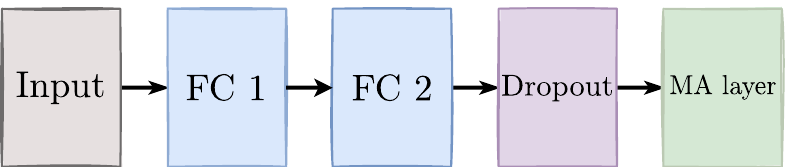
Figure 2. GCECDL-based fully connected architecture for tabular databases. FC stands for a fully connected (dense) layer. FC 1 and FC 2 use a selu activation. A dropout layer (Dropout) is included to avoid overfitting. The MA layer contains two fully connected layers that output the hidden ground truth label and the annotator’s reliability, fixing a softmax and a sigmoid activation, respectively. conv1